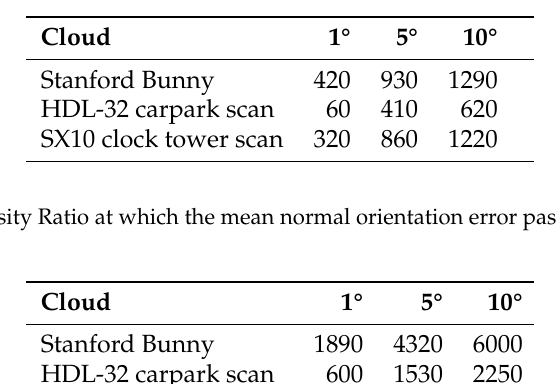
Table 2. Distance-Density Ratio at which the mean normal orientation error passes X° when calculated with floats.